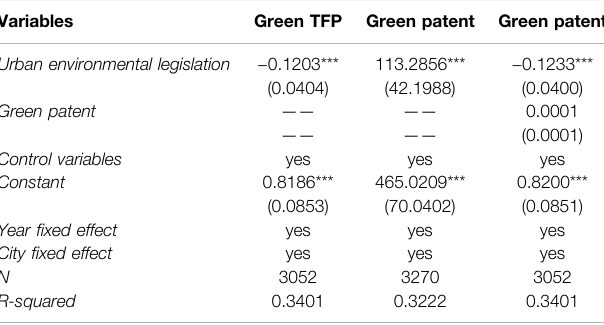
TABLE 10 | Regression results of the intermediary